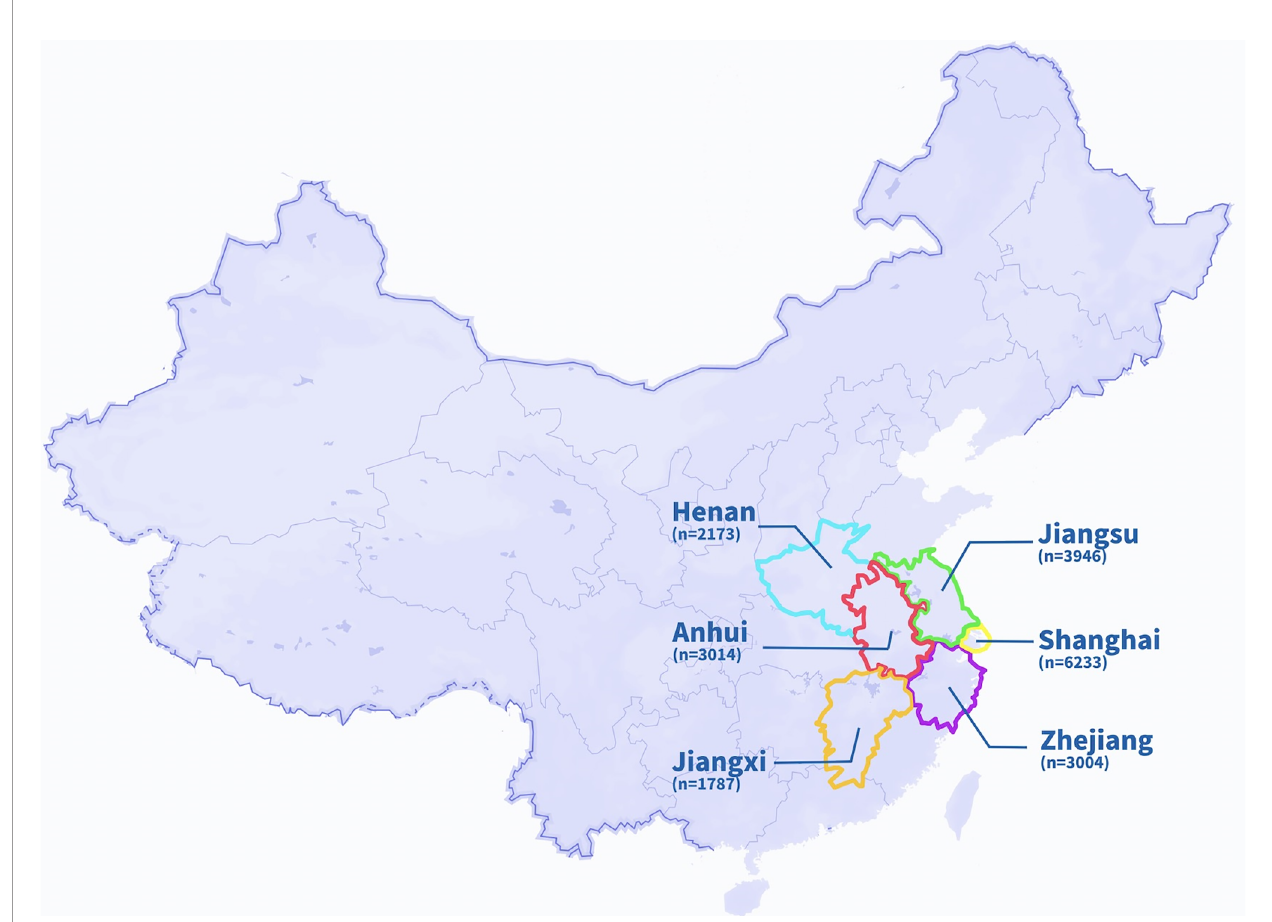
FIGURE 1 | Locations of the six districts in